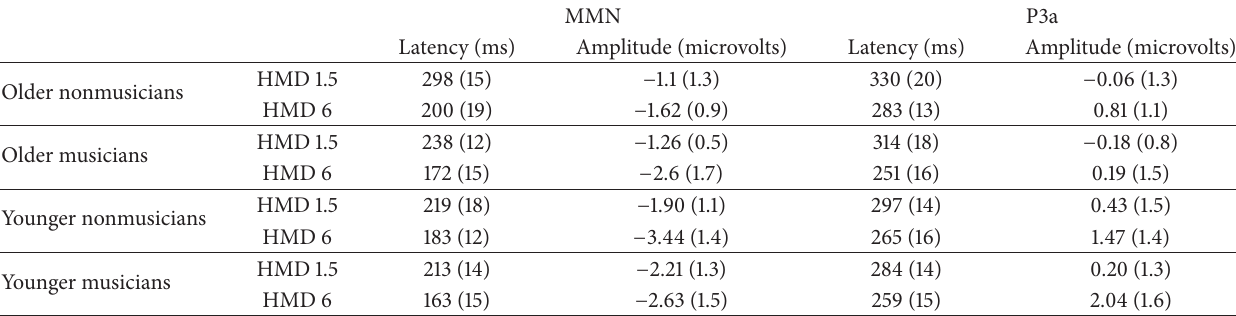
harmonic tones (HMD 1.5 and HMD 6) from older and younger musicians and